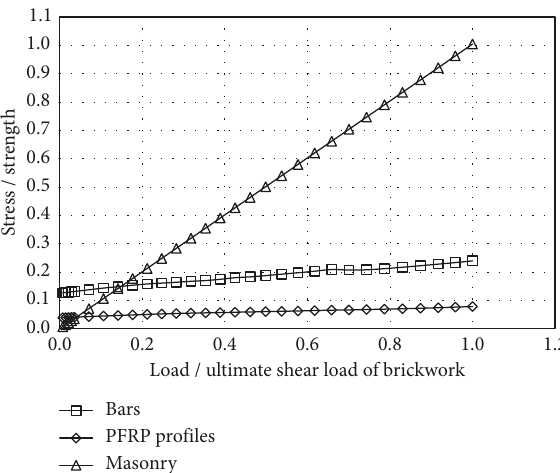
Figure 14: Stress rate in the masonry, bars, and GFRP profiles at increasing load, FE